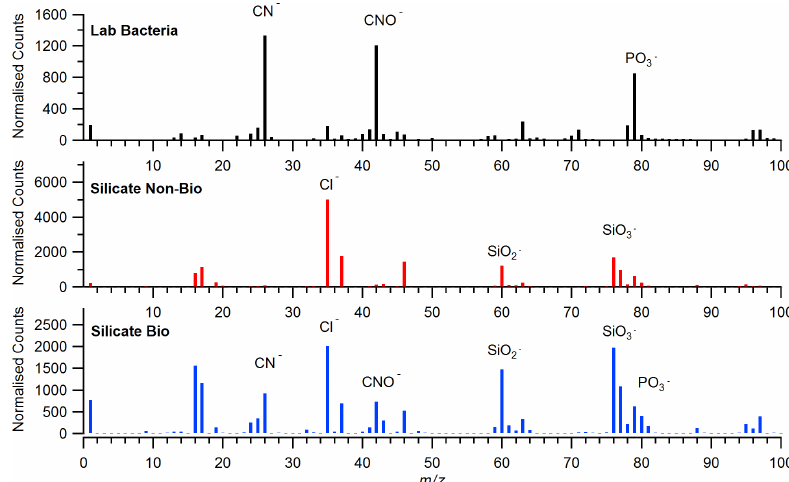
Figure 8. Average negative ion spectra of laboratory-generated bacteria and the ICE-D silicate dust